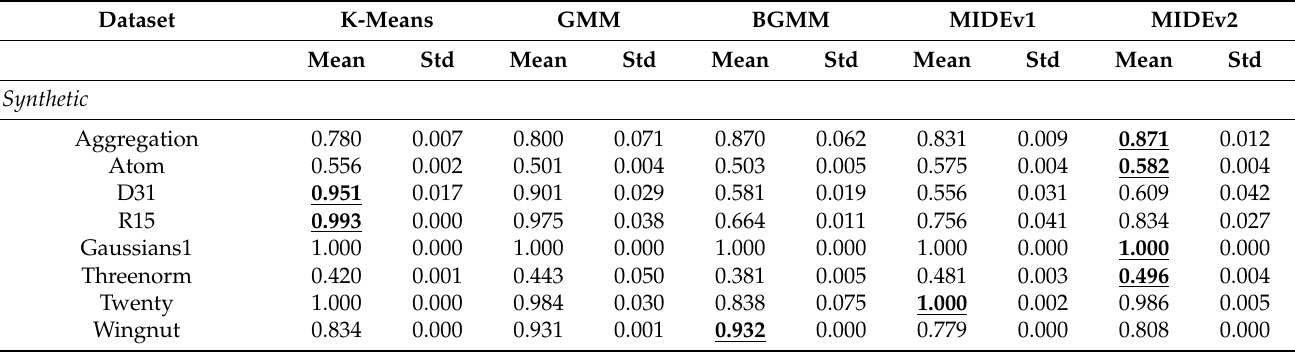
Table A3. Comparative table of different models (means and standard deviation) based on the J-Score for 10,000